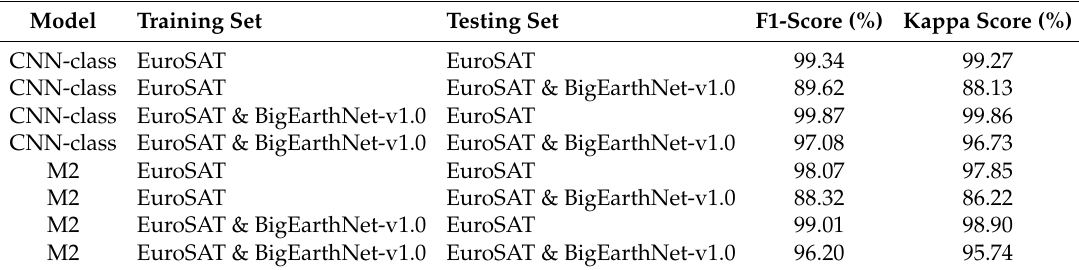
Accuracy performance of CNN-class and adapted ResNet50 (model M2) on the 10-class patch-based classification problem, computed via tenfold cross-validation, and using data augmentation based on image transformations. The training, validation, and testing sets have been partitioned according to the rule